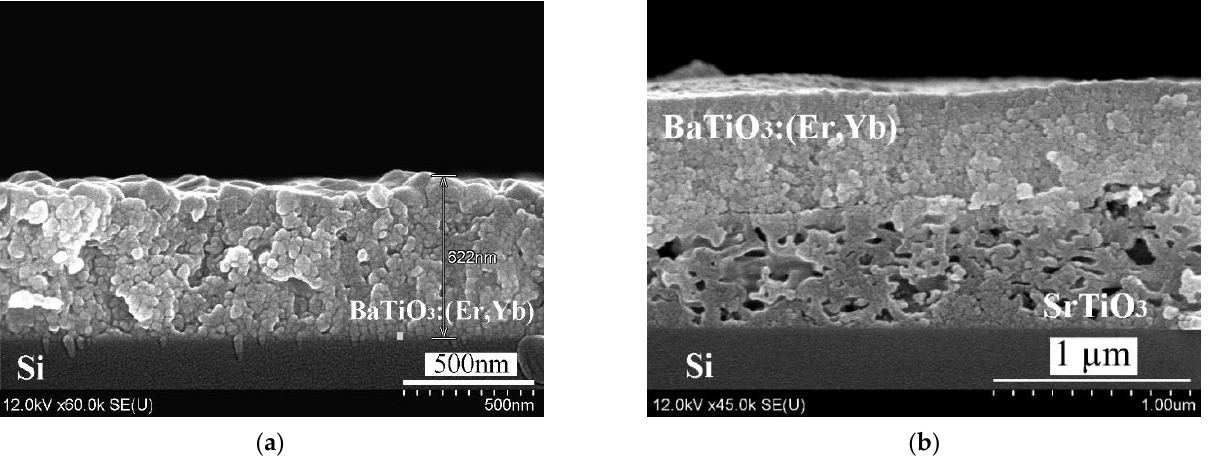
Figure 1. SEM-images of BaTiO 3 :(Er,Yb) xerogel layer deposited directly on a monocrystalline Si wafer (Sample C) ( a ) and on the same wafer using an intermediate macroporous SrTiO 3 xerogel sublayer (Sample D) ( b ).